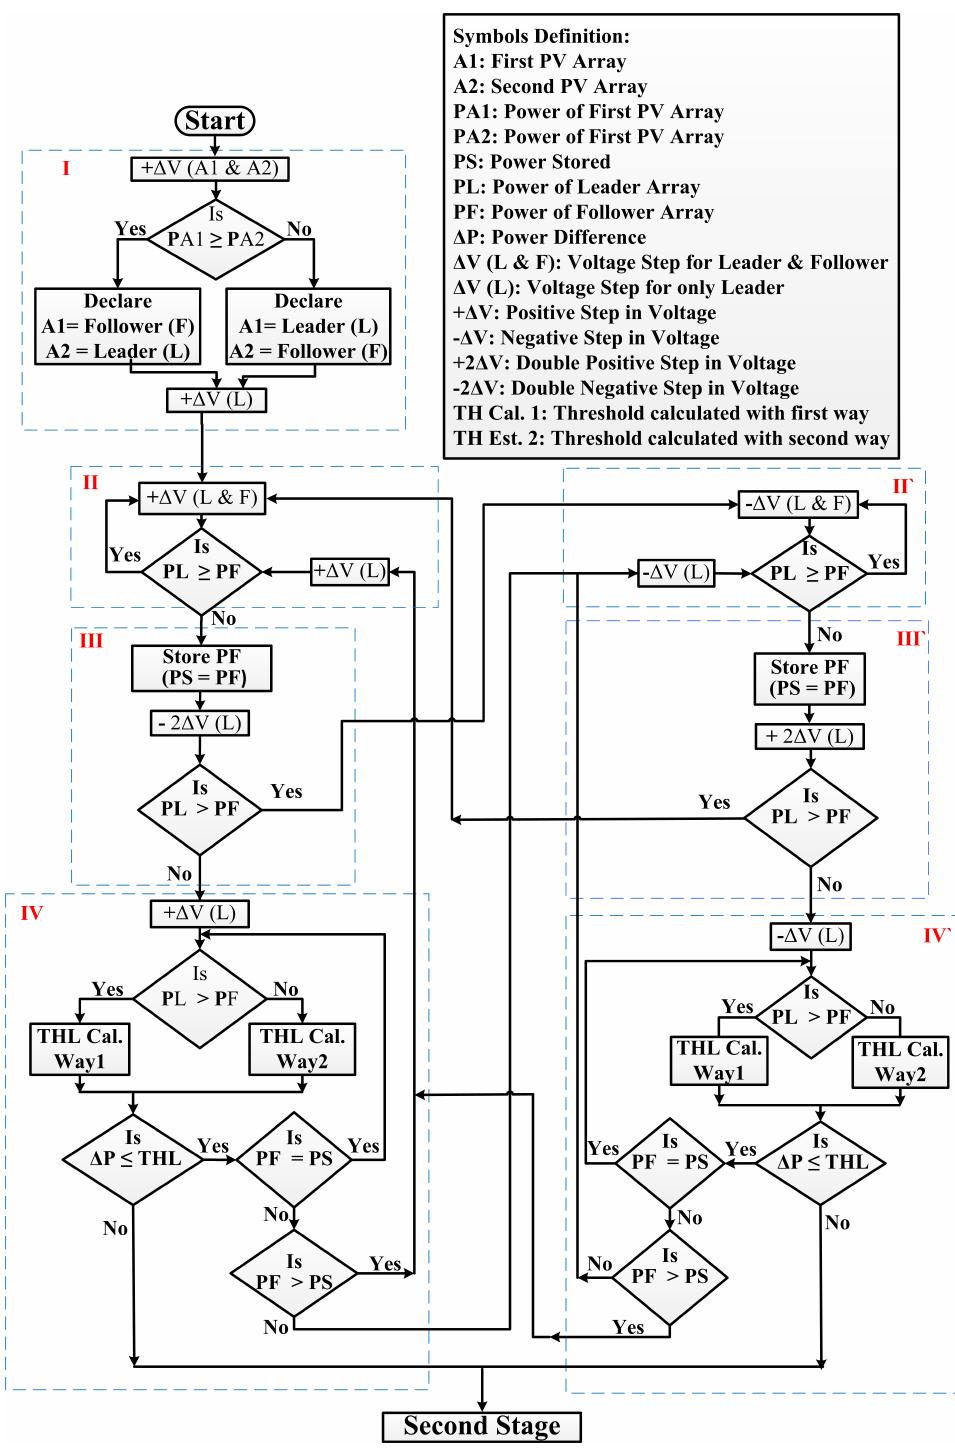
Figure 4. Flowchart of Stage 1 of the proposed